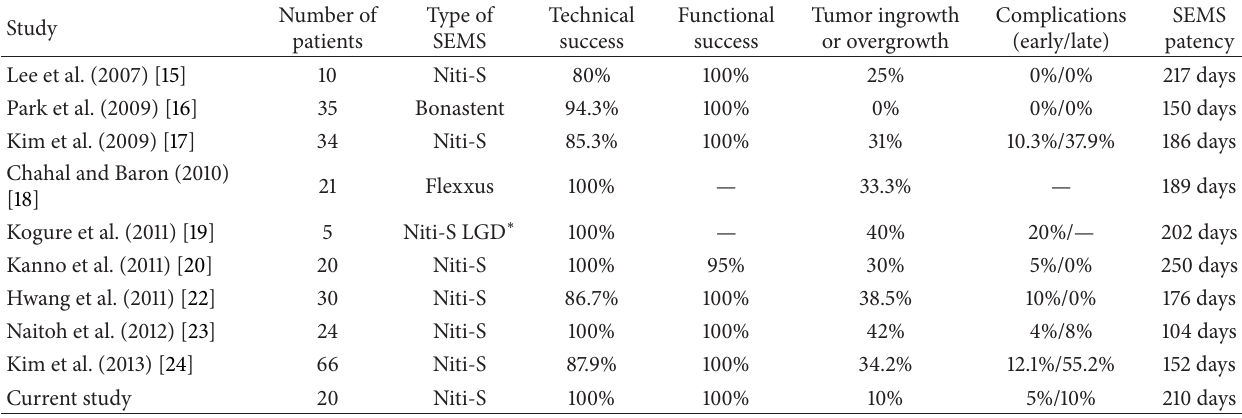
Table 1: Studies on bilateral self expandable metallic stent placement in malignant hilar